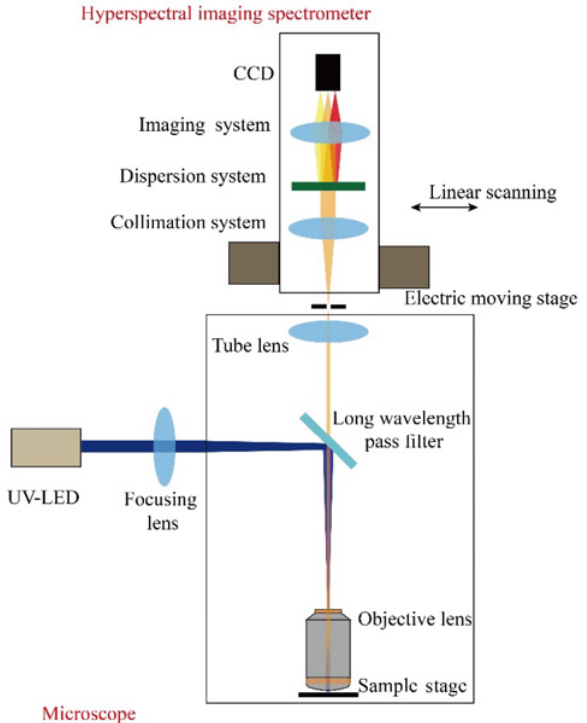
Fig. 1 Schematic of microscopic imaging spectroscopy.